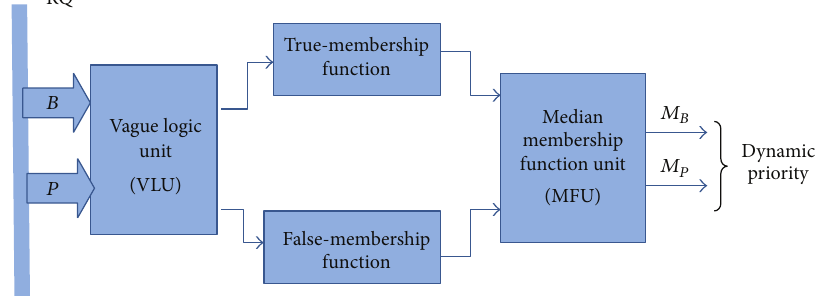
Figure 4: Vague inference